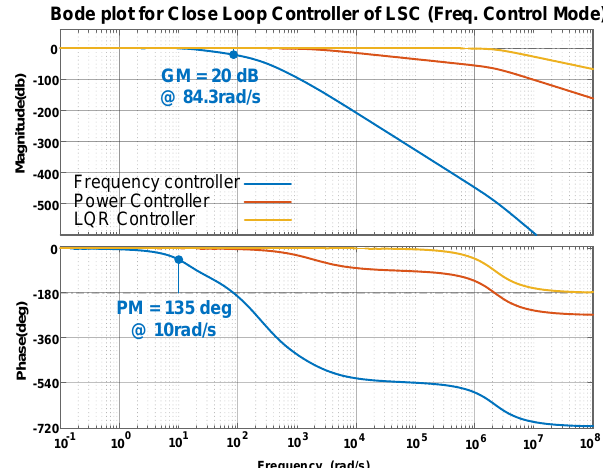
Figure 14. Frequency response plots of LSC operating under frequency control mode.